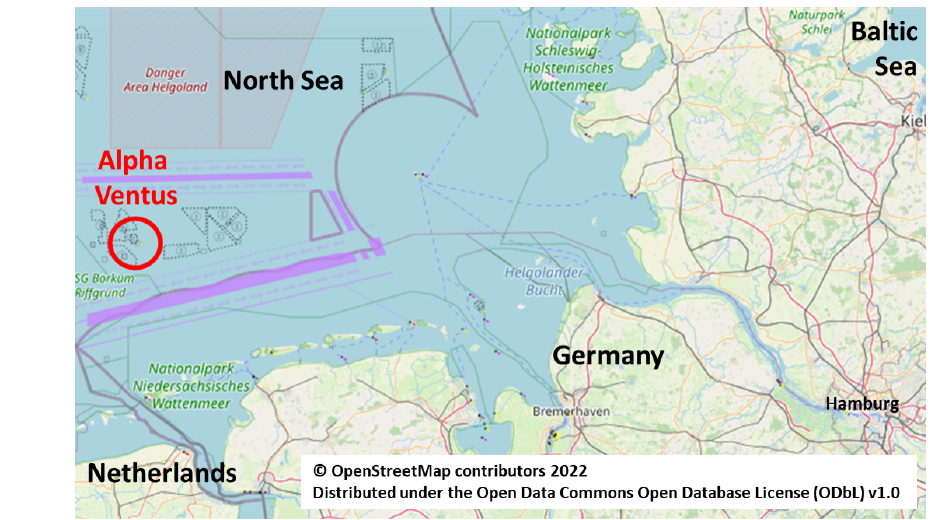
Figure 2. Location of Alpha Ventus and the met mast FINO1 (adapted from OpenStreetMap).